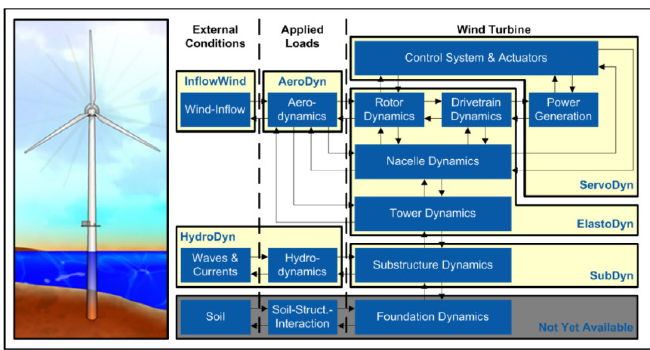
Figure 1. The simulation procedure of FAST (National Renewable Energy Laboratory, or NREL).